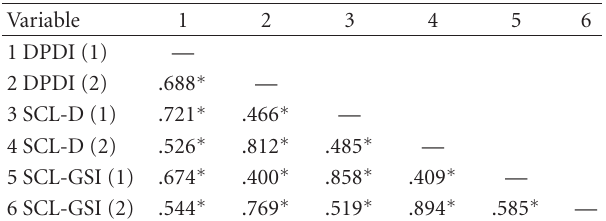
Table 2: Correlations between DPDI, Depression, and GSI at pre- and posttreatment.